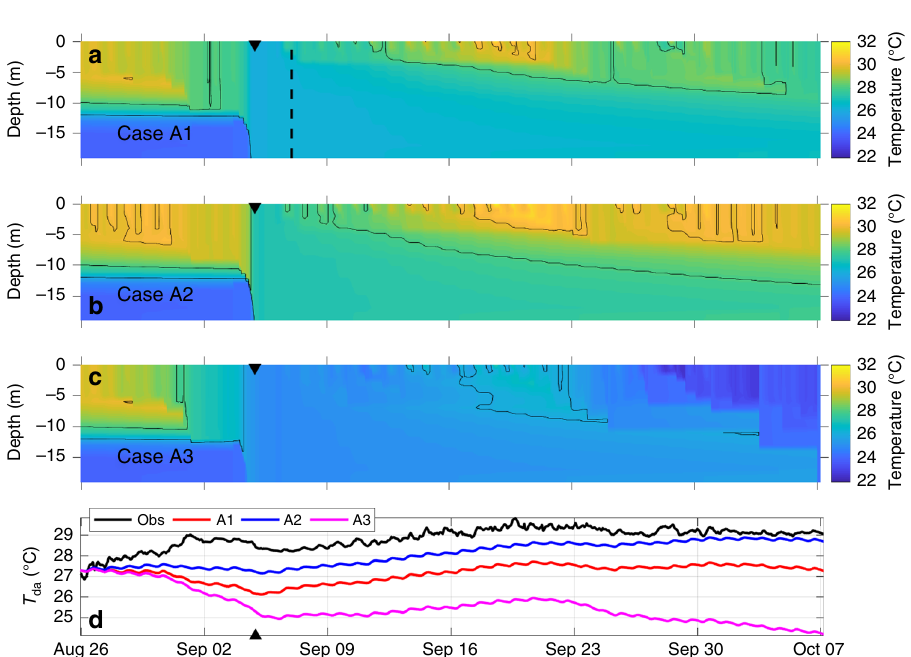
Fig. 3 Times series of the model results for cases A1 – A3. The modeled temperature structure from cases a A1, b A2, and c A3 as well as d the comparison between the observed (Obs) and modeled depth-average temperature, with the fi lled triangles indicating the landfall time of TS Gordon (9/4/ 2018). The three model cases differ in the parameterization of the heat fl ux terms and their use of observed or modeled SST with details provided in the “ Methods ” section and Table 1. Accounting for the cold bias associated with response to TS Gordon, case A1 in ( d ) best captured the depth-average temperature response after the impact of TS Gordon with r = 0.89. The case A1 parameterization was used in the subsequent model experiments (cases B ’ s and C ’ s in Table 1) with the black vertical dashed line in ( a ) marking the post TS Gordon period (9/7/2018) when the subsequent model runs